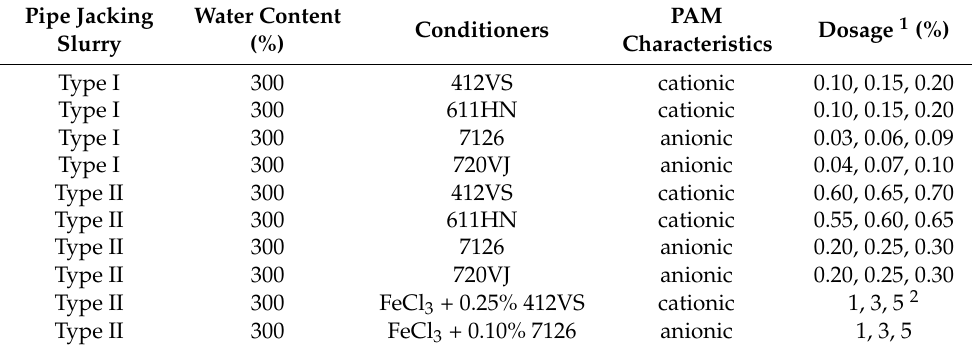
Table 3. Conditioning scheme of waste slurry.